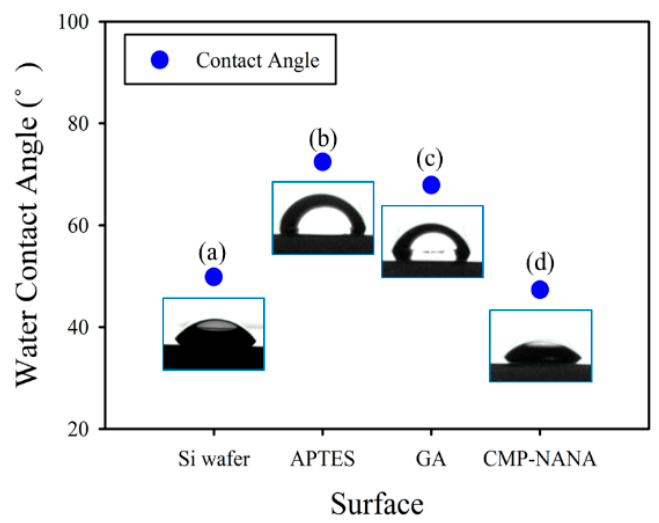
Figure 6. Water droplet contact angle measurements on four di ff erent functionalized Si wafer surfaces.